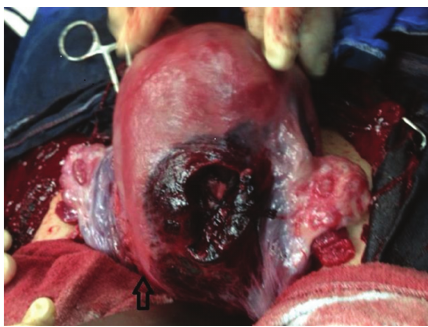
Figure 1: Arrow indicates actively bleeding vein.